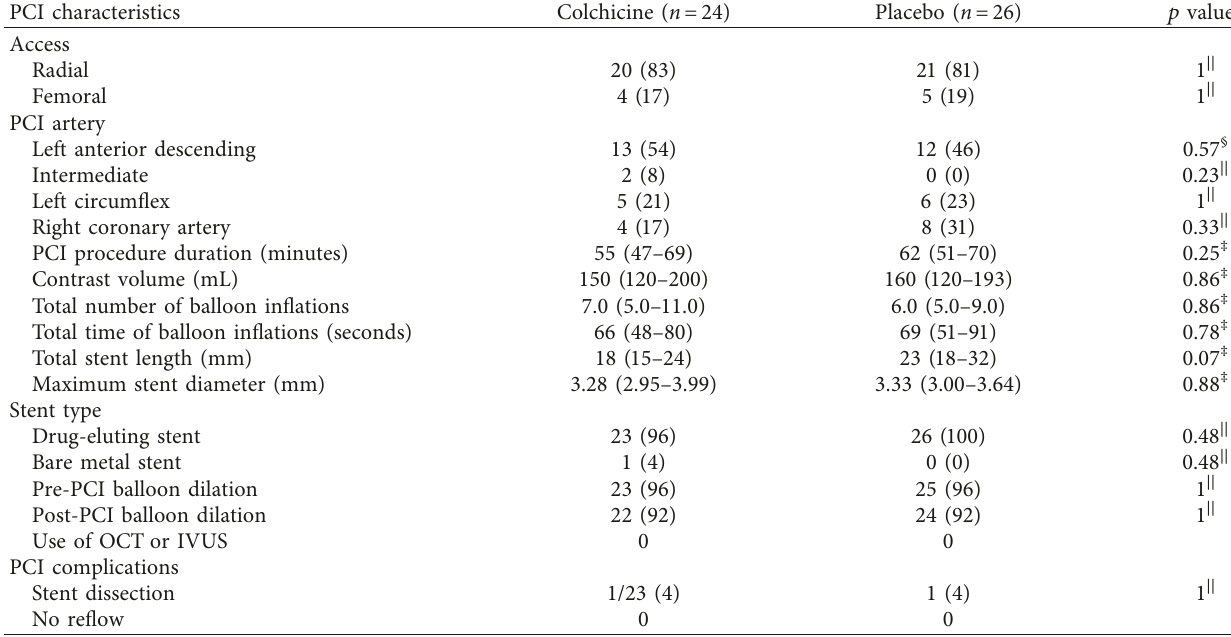
Table 2: PCI characteristics, by study drug